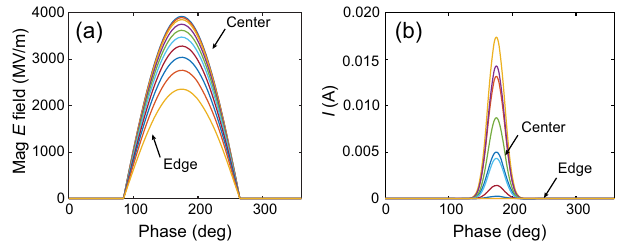
FIG. 4. (a) Magnitude of the electric field at the points shown in Fig. 3. Half of the rf cycle is shown which is the correct orientation for acceleration. (b) The current versus phase based on the fields in (a). Most emission comes from the center and surrounding area. While the field is highest at the center of the tip, the current is higher at some points because they represent a larger area in a high-field region. The current density is highest at the tip center where the field is highest. The field is low enough at the edge of the hemisphere that it does not significantly contribute to the emission. This is reflected in the radial probability shown in Fig. 3(b).